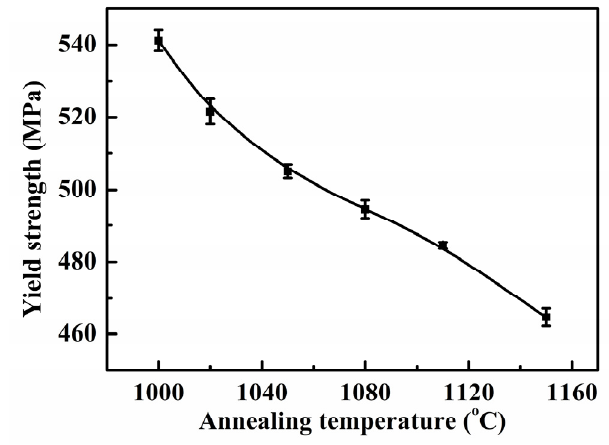
Figure 5. Yield strength of specimens with different annealing temperatures for 30 min.